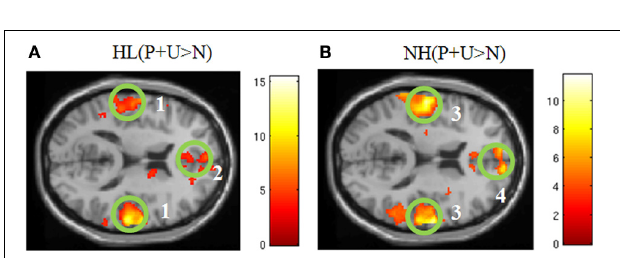
and U stimuli. Compared to the NH group, the HL reaction times were significantly slower for P and U sounds. (B) Mean number of responses. The NH and HL groups responded U significantly more than N and P. Statistical significance level p < 0 . 05 indicated by ∗ .